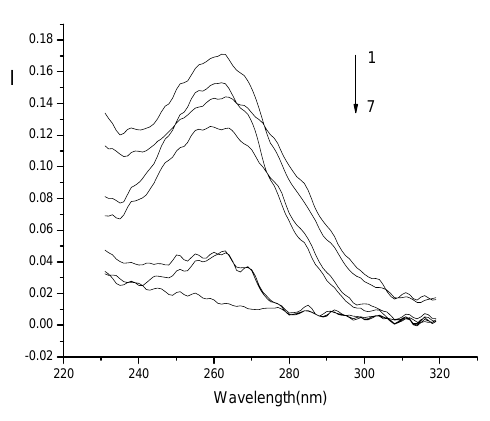
Figure 6 . Absorption